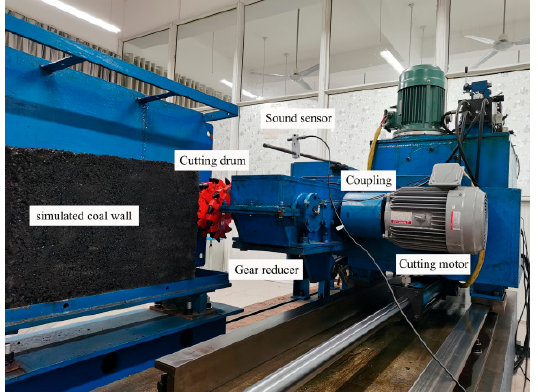
Figure 3. Shearer simulating cutting experimental system.